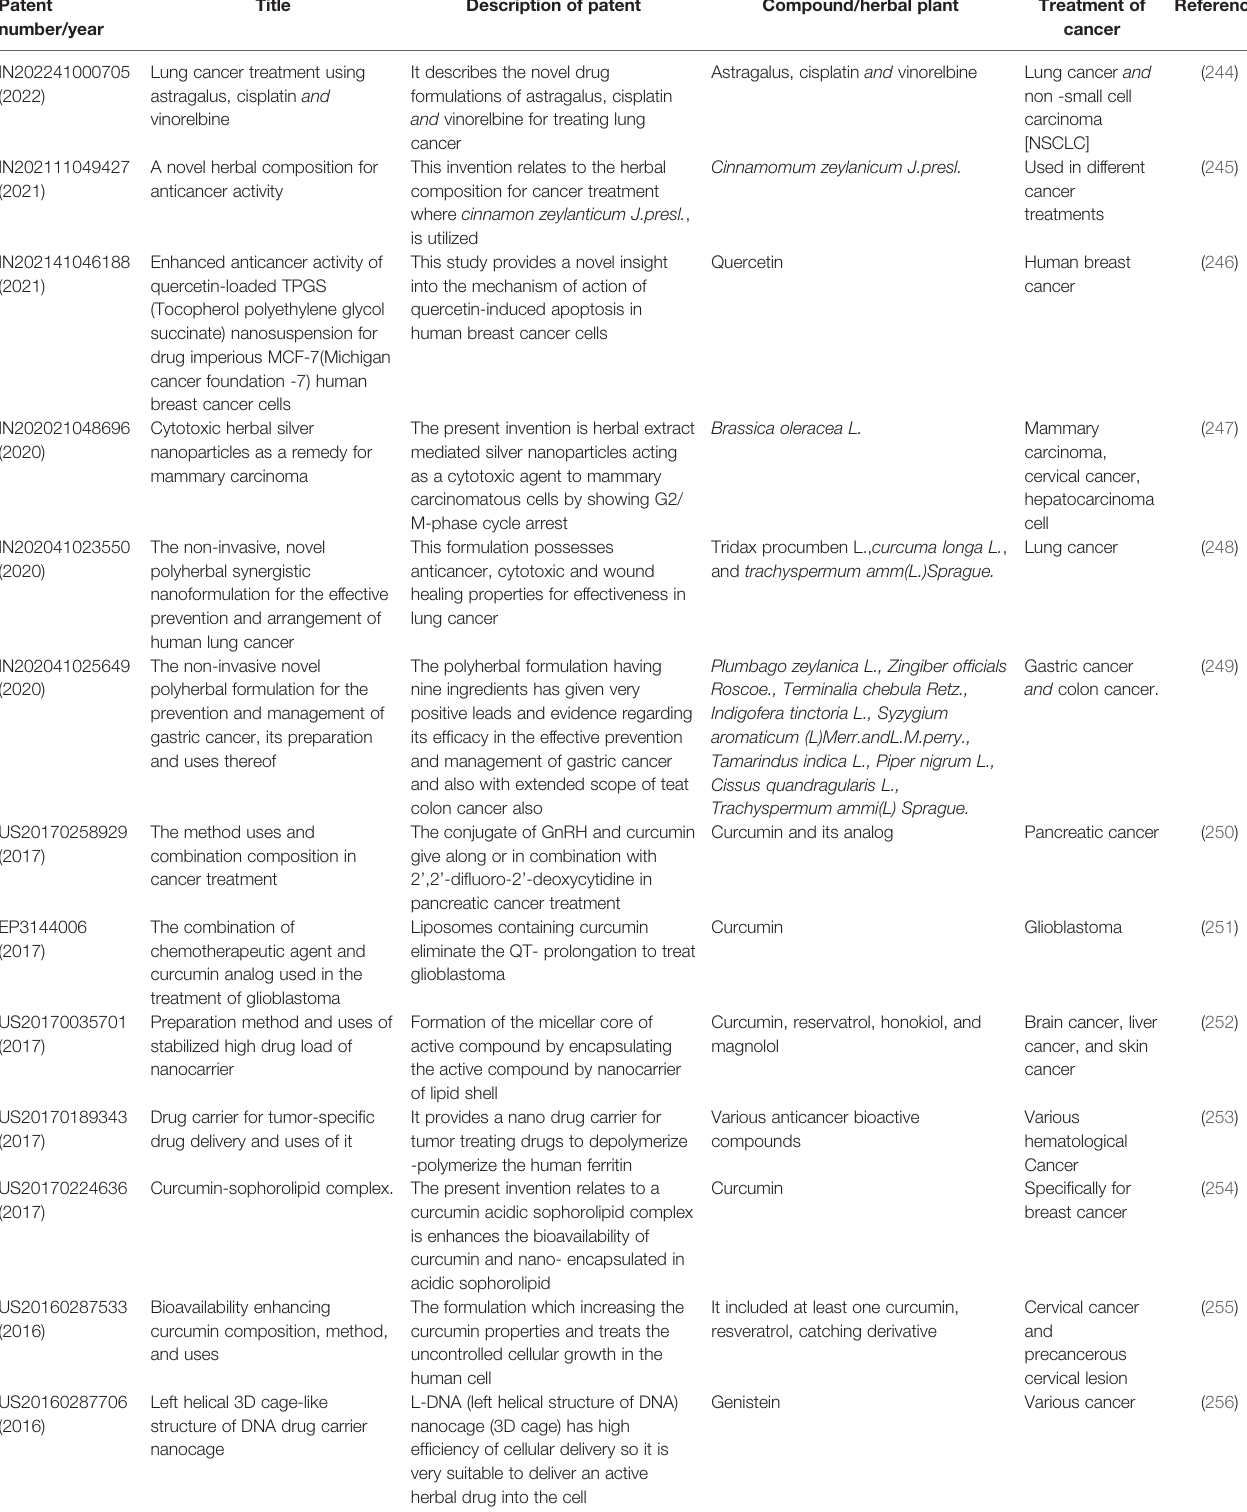
TABLE 3 | Summary of recently published patents related to nanoparticle formulation with the natural anti-cancer molecule. Patent Title number/year